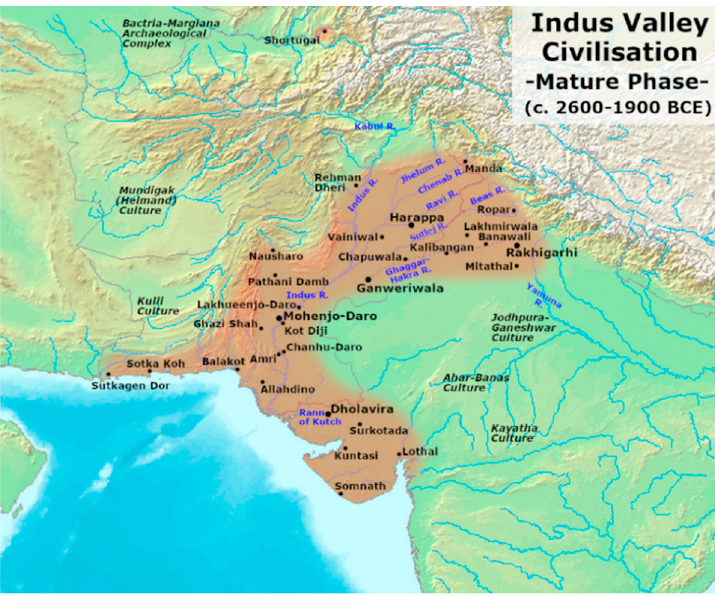
Figure 2. The geographical extent of the Indus valley civilization (source: https://commons.wikimedia.org/wiki/File:Indus_Valley_Civilization,_Mature_Phase_(2600-1900_BCE).png; accessed on 7 July 2021).